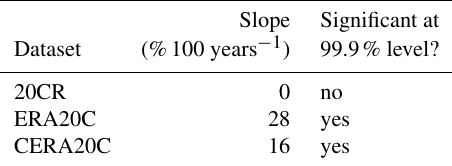
Table 1. Trend characteristics are shown. Slopes are rounded to in- teger values and the CERA20C slope corresponds to the mean of the slopes of the individual ensemble members. Significance is tested against the null hypothesis of no trend and using a two-sided t test. For CERA20C, all streams feature significant trends